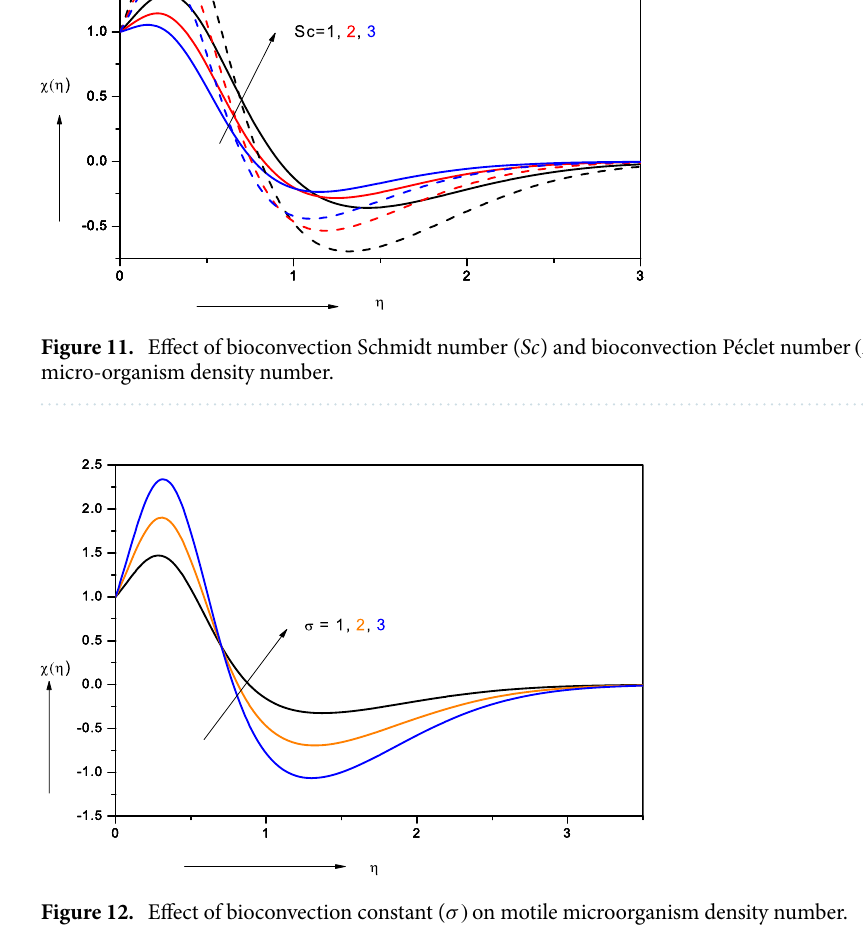
Figure 12. Effect of bioconvection constant ( σ) on motile microorganism density number.